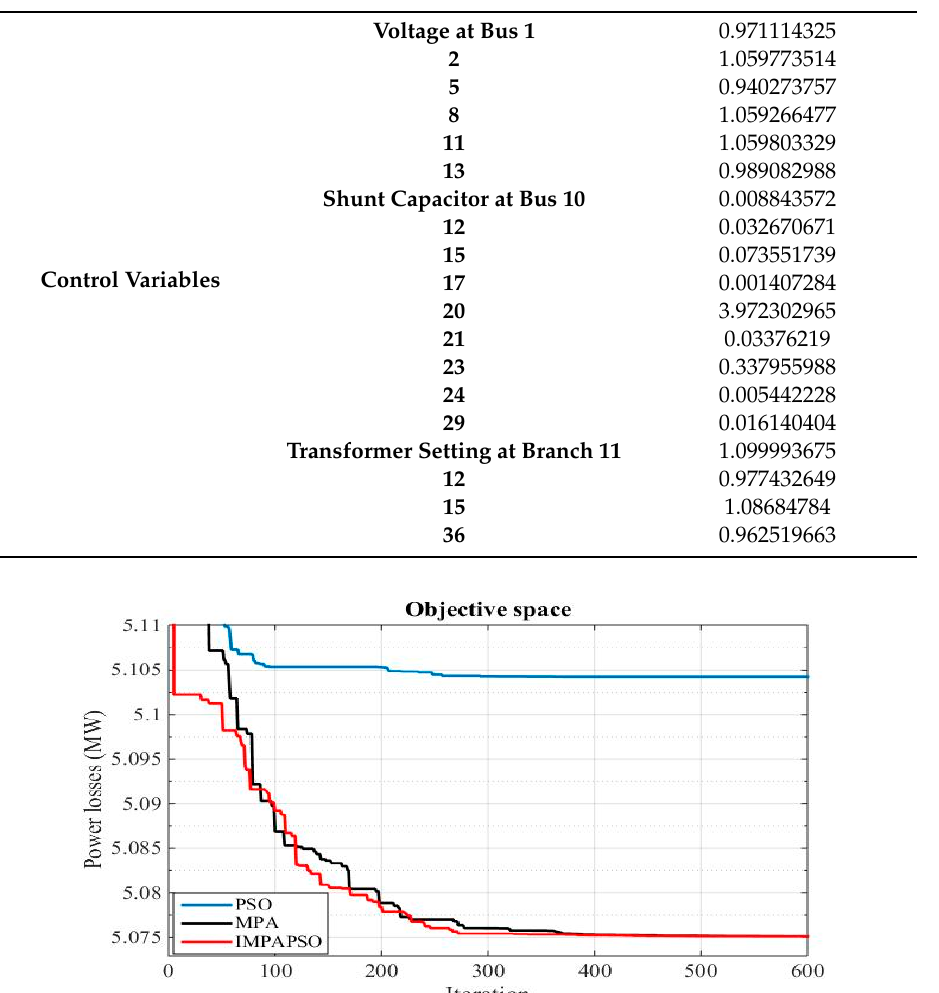
Figure 3. Convergence of PSO, MPA, and IMPAPSO in the first case of the IEEE 30-bus system. Table 1. IEEE 30-bus system’s first case objective performance.